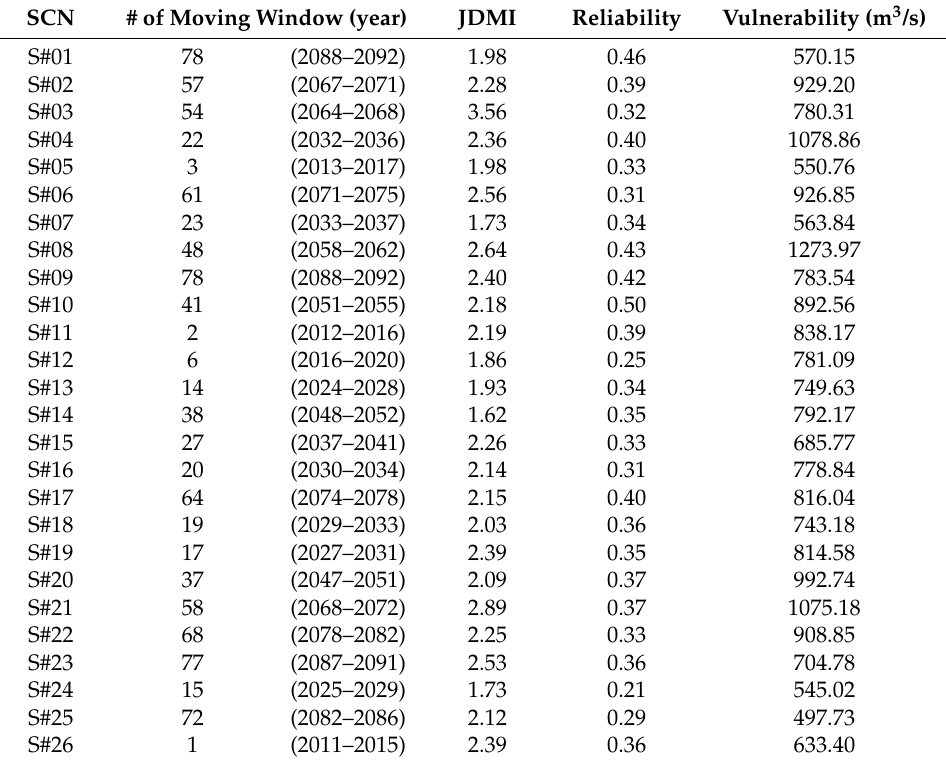
Table 5. Maximum events based on JDMI of each scenario and the corresponding values of reliability and